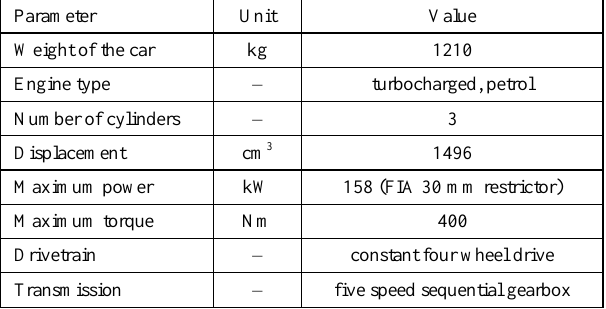
Table 1. Basic technical data of the Ford Fiesta ST Rally3